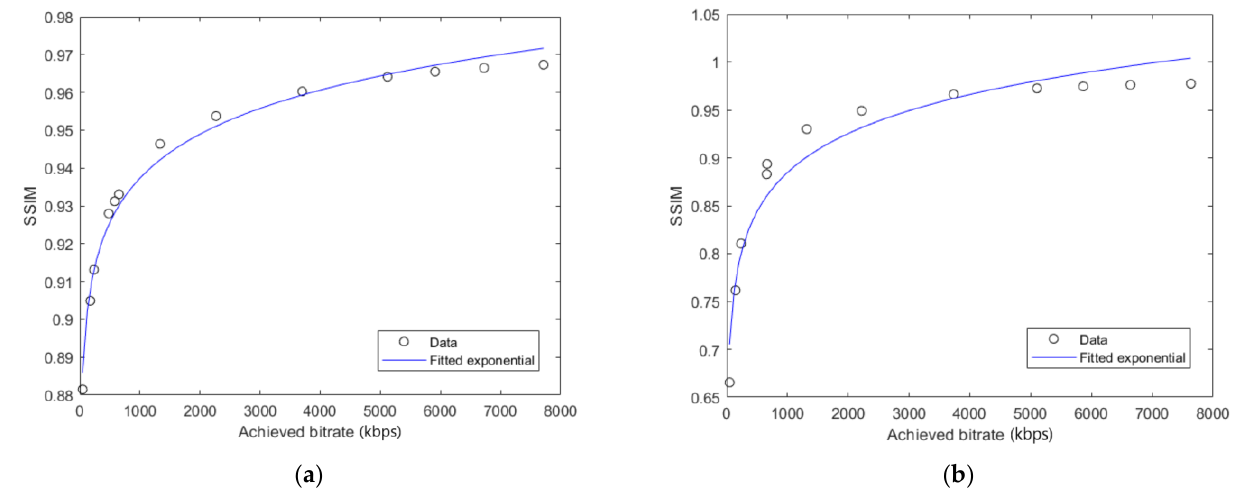
Figure 3. Fitted curves of data points presenting the envelope of SSIM-achieved bitrate curves for video sequences: ( a ) Chimera 1102347 (C47); ( b ) Pedestrian Area (PA).